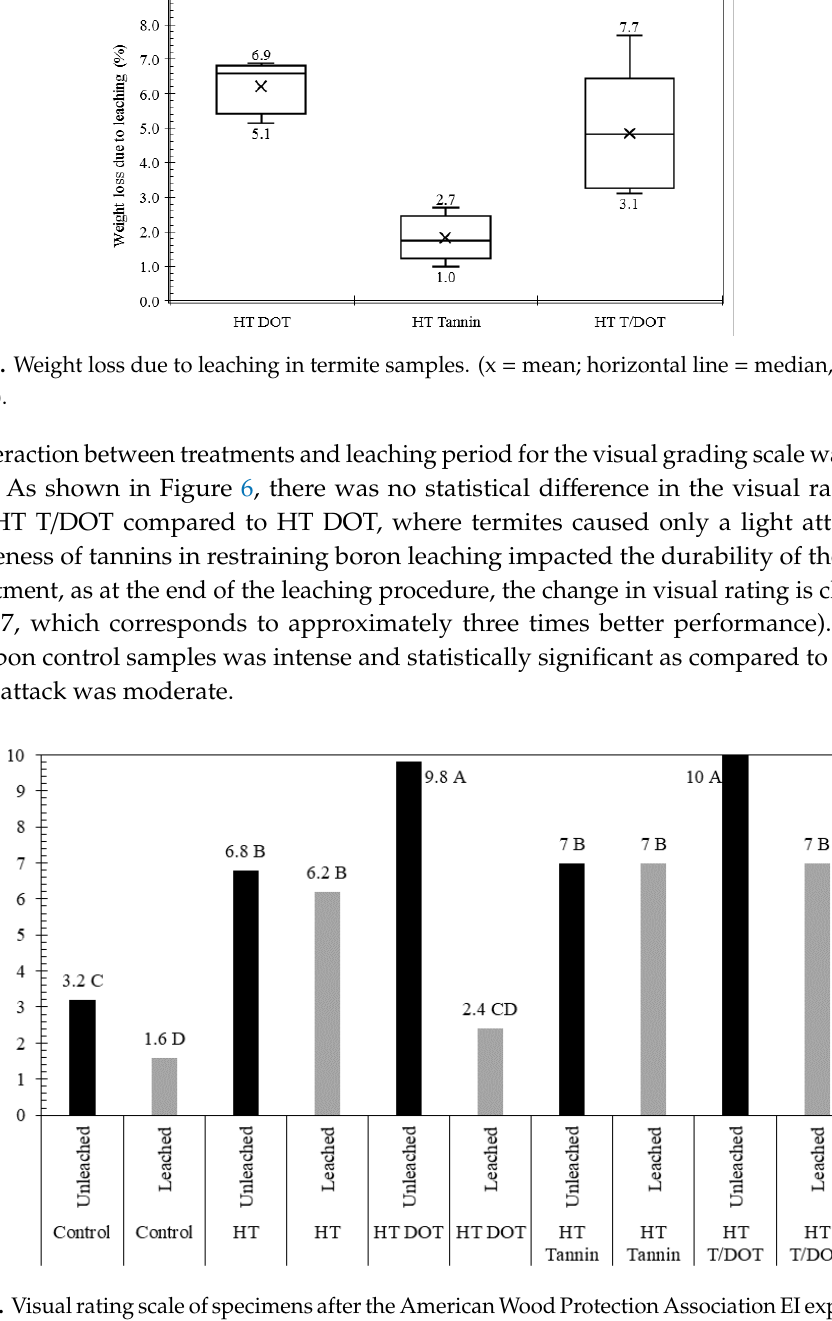
Figure 6. Visual rating scale of specimens after the American Wood Protection Association EI experiment. Values followed by the same letter were not statistically different by Least Square Difference multiple comparison test at the 0.05 significance level.